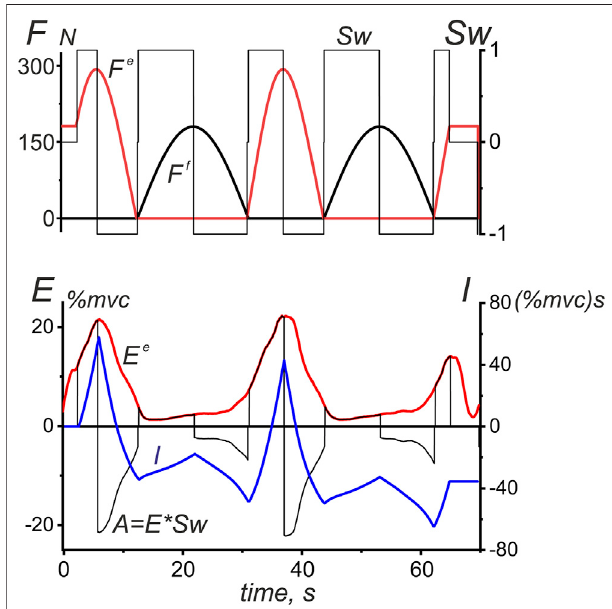
FIGURE 7 | A procedure used to integrate the EMG intensity in the antagonist muscles of a given joint during the ascending and descending phases of successive force waves. An example is the EMG reaction of TrLat shown earlier in Figure 3 . The switch function Sw at the upper plot is de fi ned by Equation 3 , and the integration procedure for the EMG intensity ( I ) is applied to the auxiliary function A = E*Sw; the integration result is an oscillatory process that correlates with the original EMG intensity curve, at the same time, stressing more distinctively differences between EMG areas at the ascending and descending phases of the force waves. The difference between the maximum and minimum points at each section of the integral curve ( I ), where this function changes monotonically, gives us a strict value of the EMG intensity area within the corresponding time intervals. The integral curve I makesitpossibletomoreclearlyrepresentthedifferencesbetweenthe central commands acting on the studied muscles on the ascending and descending branches of force